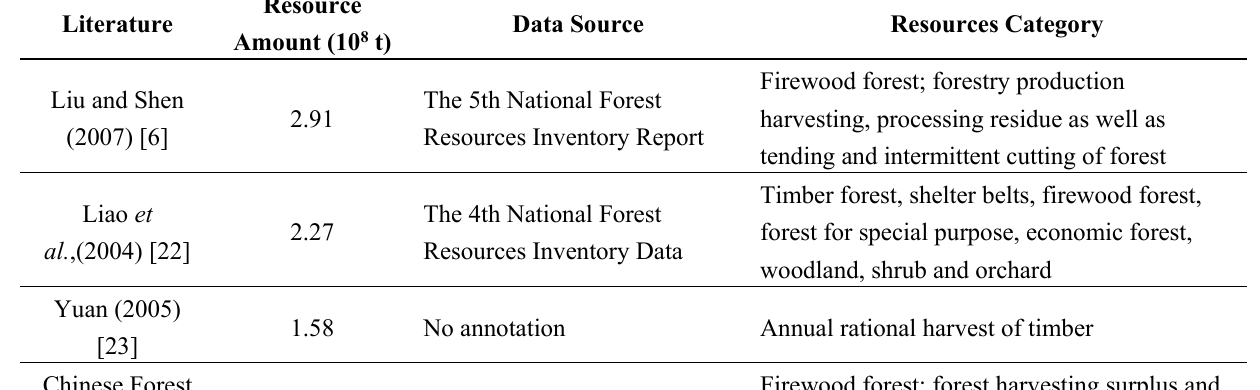
Table 3. Comparison of forest biomass energy resource research results in